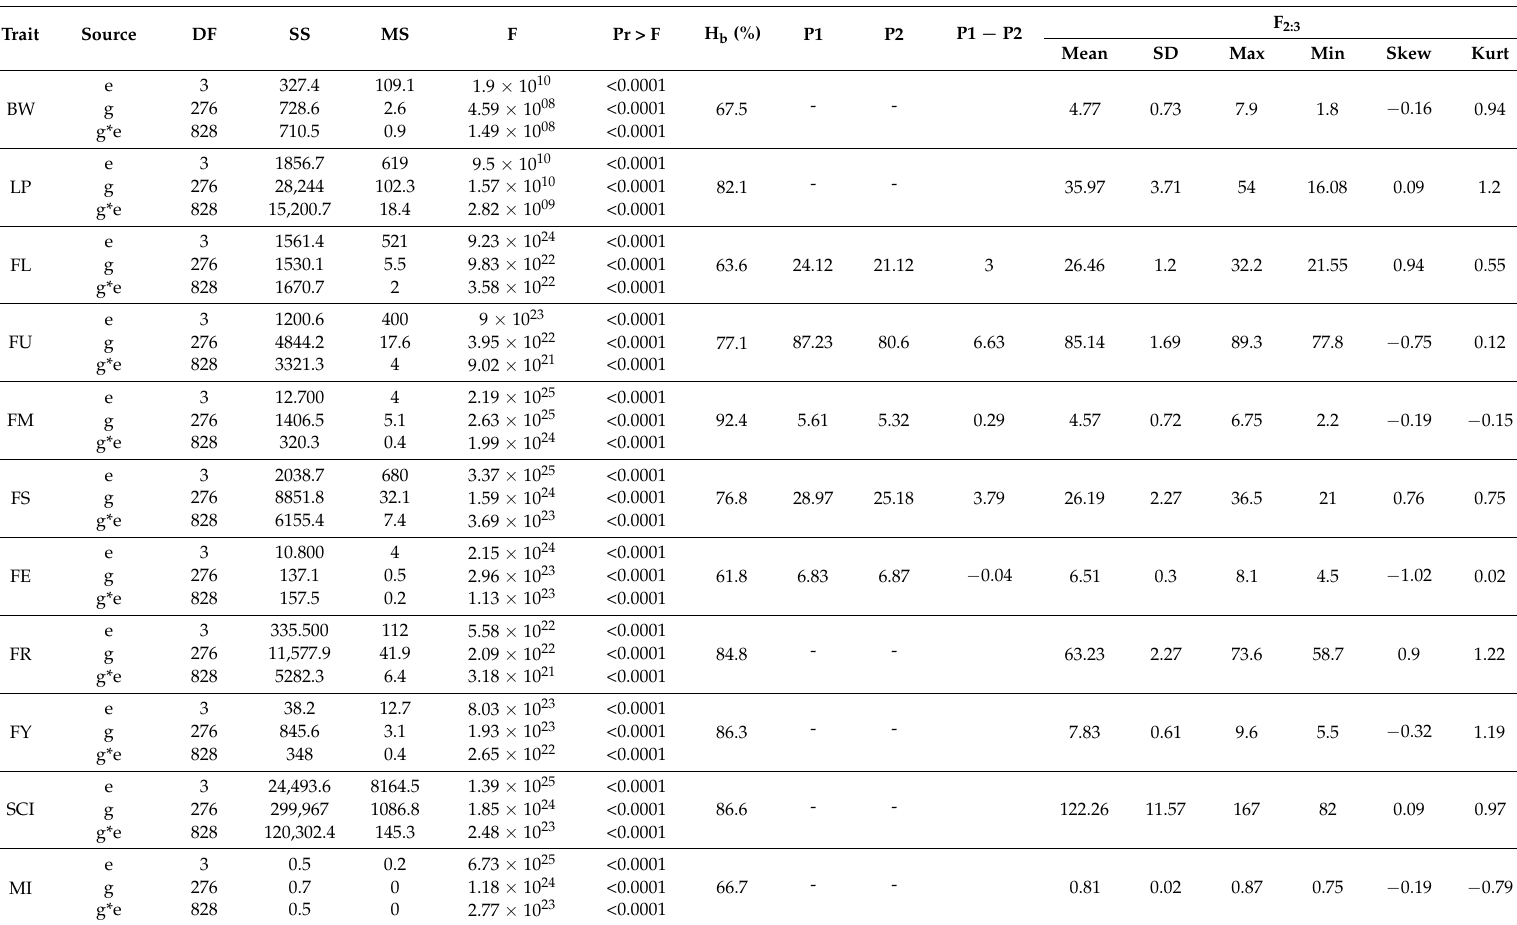
Table 1. ANOVA, broad sense heritability and phenotypic analysis of fiber quality and yield related traits for the two parents and the F 2:3 population.